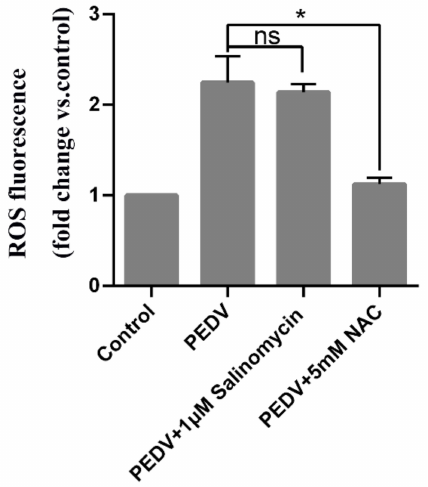
Figure 6. Inhibition of PEDV replication by salinomycin is independent of reactive oxidative species (ROS) generation. Vero cells subjected to pretreatment with NAC (5 mM) or salinomycin(1 µ M) for 1 h, were infected with PEDV along with NAC or salinomycin. At 24 hpi cellular ROS were detected using H 2 DCFDA (5 µ M, 30 min). Values represent three independent experiments. Significant differences compared to untreated infected cells are indicated by *, (* p < 0.05), ns, no